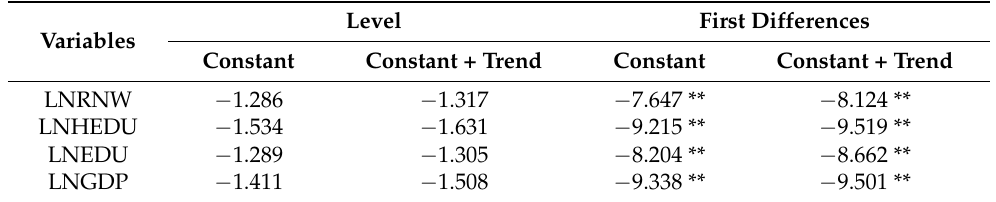
Table 6. CIPS unit root test results.